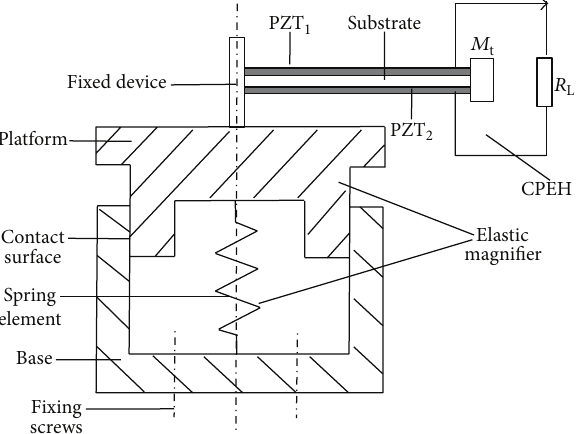
Figure 1: Configuration of proposed